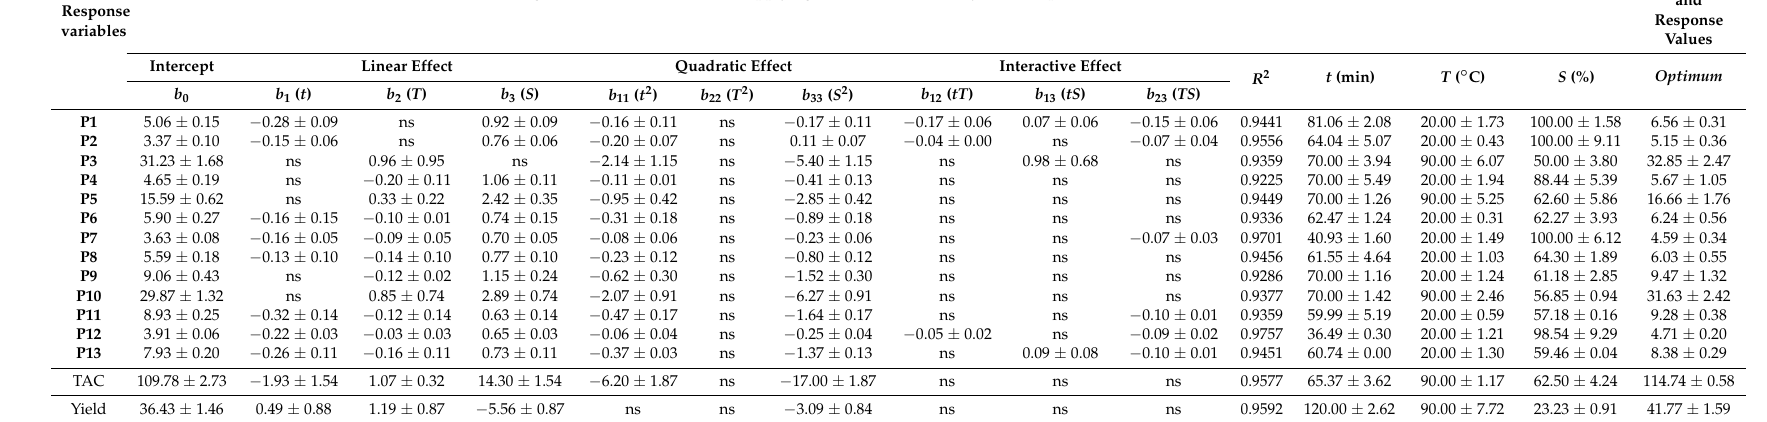
Table 3. Estimated coefficients and R 2 determined for the models obtained for individual and grouped anthocyanin compounds and extraction yield (Table 3), and optimal HAE conditions and response